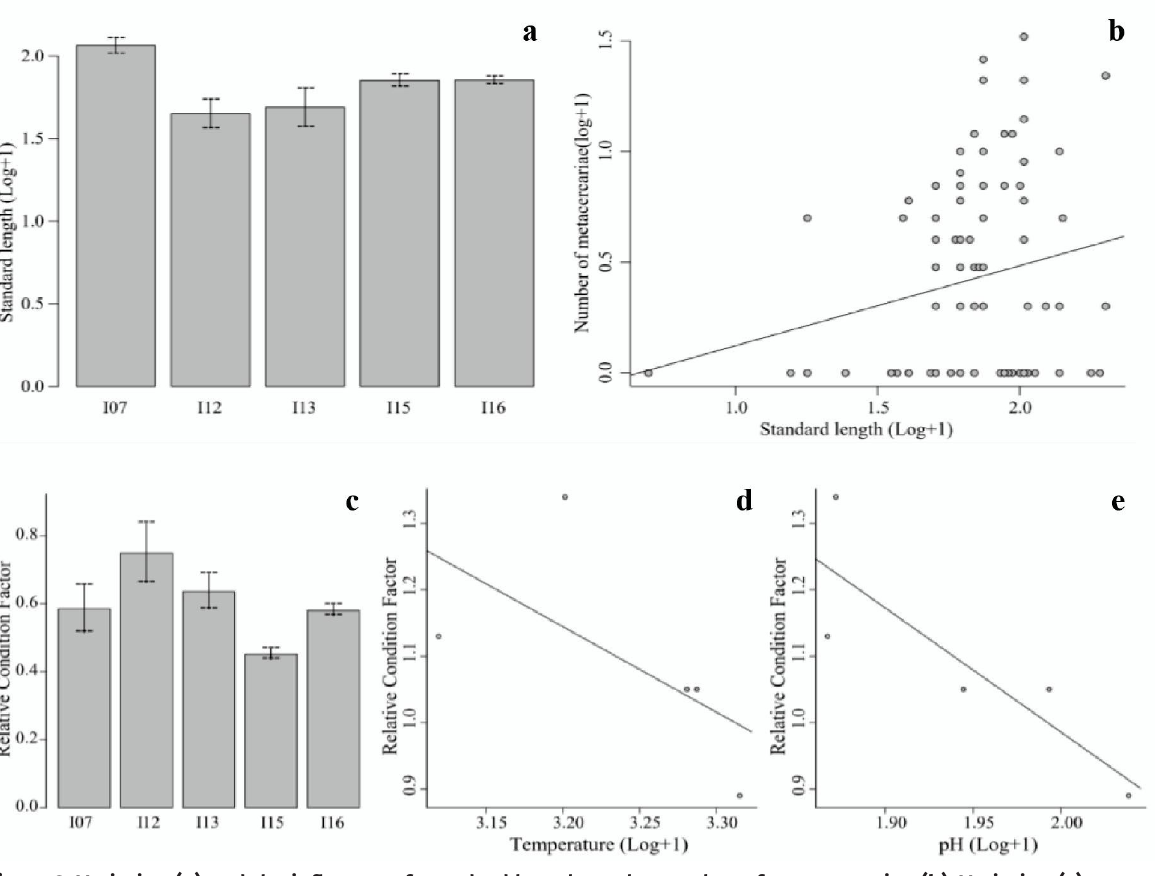
Figure 3. Variation (a) and the influence of standard length on the number of metacercariae (b) . Variation (c) and influence of temperature (d) and pH (e) on the relative condition factor of Cichlasoma paranaense in impoundments sampled in Itauçu (I07, I12), Inhumas (I13) and Goiânia (I15 and I6), Goiás,